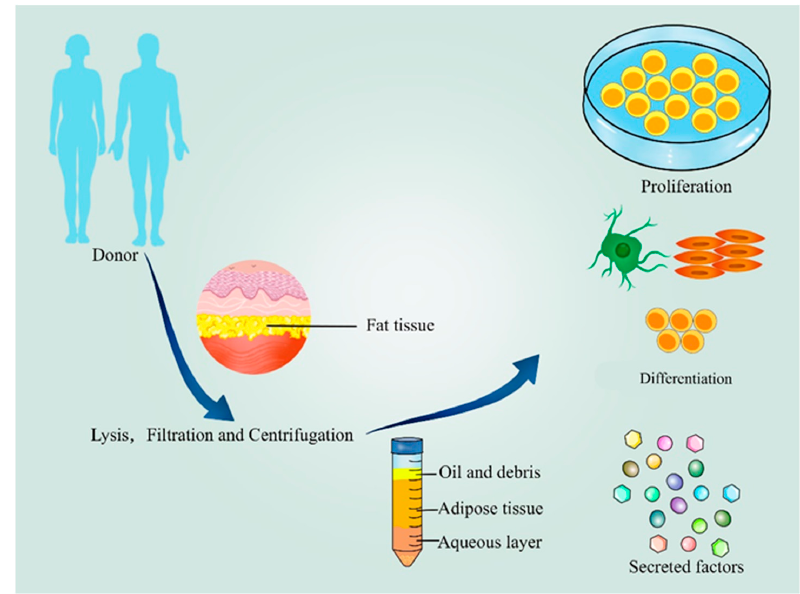
Figure 1. Extraction, proliferation, differentiation, and secretion of ASCs.